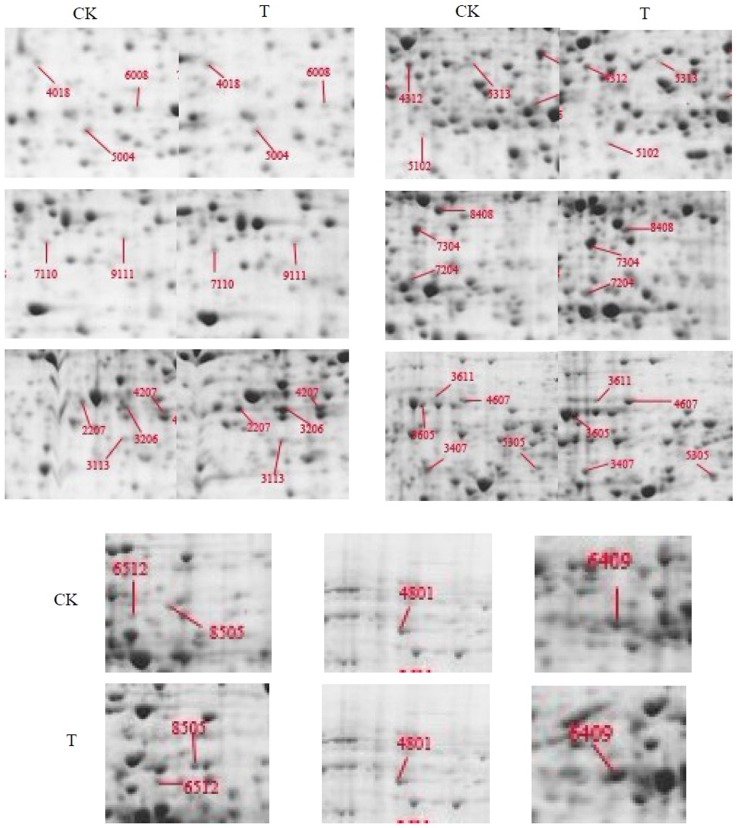
Comparison of the differential proteins expression level in two groups.CK: the control, samples treated with cotton balls soaked distilled water only. T: the test, samples treated with cotton balls soaked 0.8% (8 mg/mL) colchicine solution.